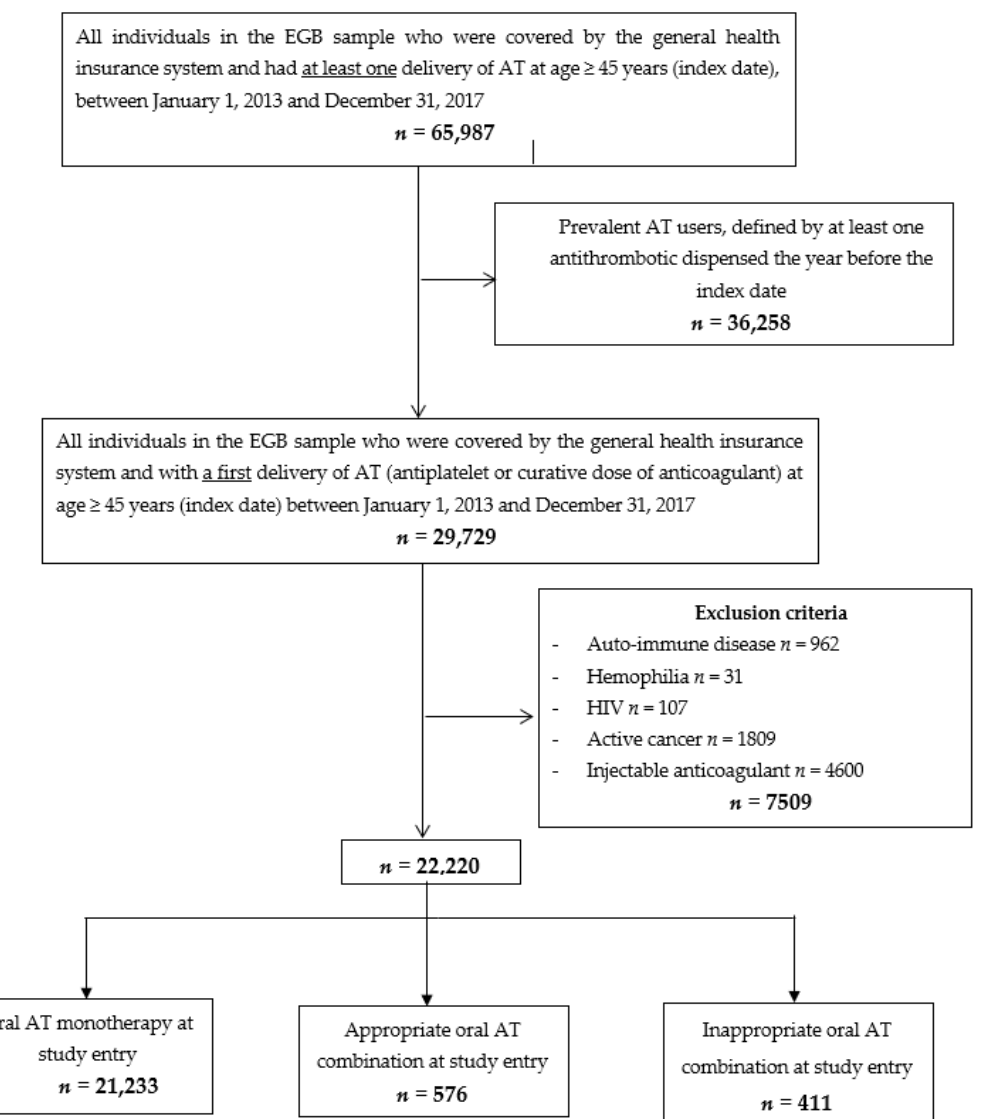
Figure 1. Flow chart. Abbreviations: EGB: é chantillon g é n é raliste des b é n é ficiaires (general sample of beneficiaries); AT: